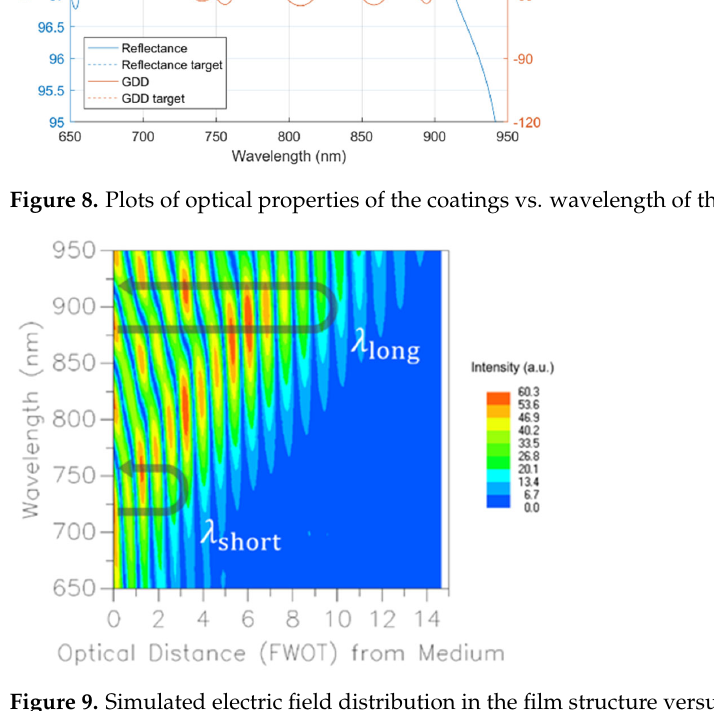
Figure 9. Simulated electric field distribution in the film structure versus wavelength.